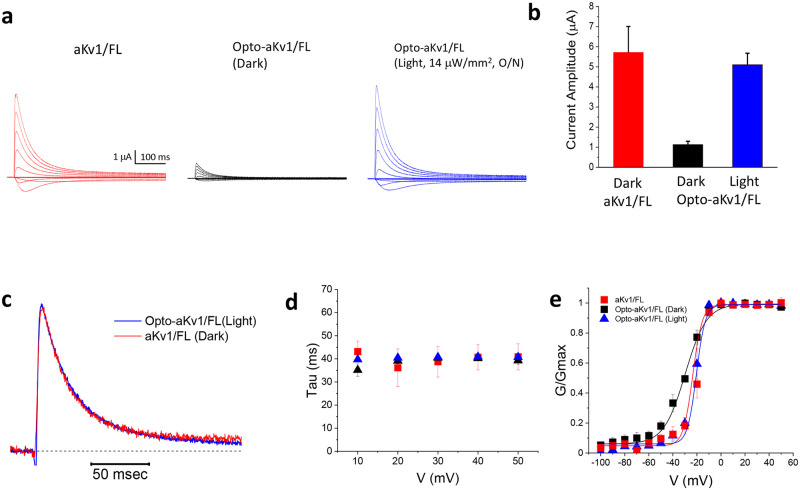
Channel expression suppressed by LOV domain and its photoactivation by light.a) Currents in Xenopus oocytes following injection of various cRNAs (aKv1/full-length and Opto-aKv1) and overnight expression at 18°C under dark or blue light conditions. Traces were elicited by voltage steps from -60 mV to +50 mV at 10 mV steps from a holding potential of -100 mV. Blue light was applied continuously for 16 hrs at 14 μW/mm2. b) Analysis of peak current amplitude at +50 mV. Results plotted as mean ± standard error (SE) (p < 0.01 Dark-Light). c) Close-up comparison of current kinetics for Opto-aKv1/FL with blue light and aKv1/FL in the dark recorded at +50 mV using elevated K+ Out. Following normalization for peak current amplitude the current waveforms are nearly identical. d) Inactivation of outward currents as measured using single exponential decay at described voltages. e) Conductance-voltage relationship of aKv1/FL channels compared to those of Opto-aKv1/FL in the dark or light. Results are shown as mean ± SEM.